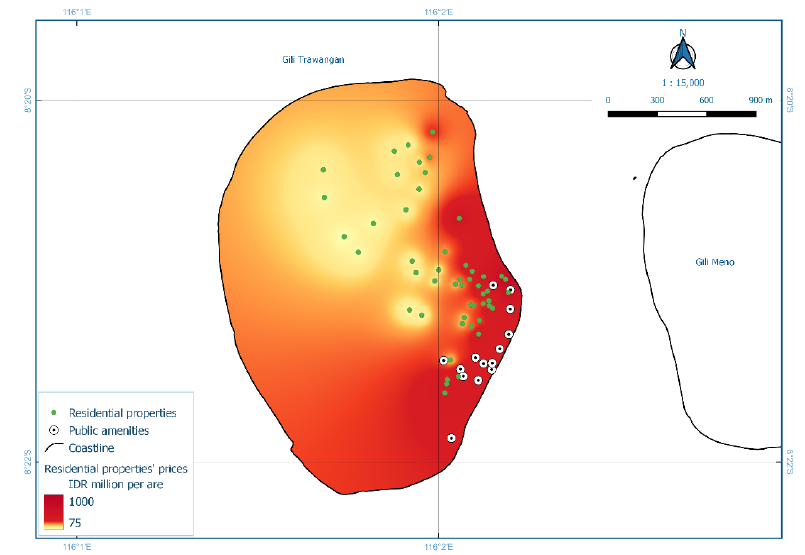
Figure 6. Interpolation of residential property prices for Gili Trawangan Island (Model HR2). The third model, Model HR3, analysed residential property prices for Gili Air